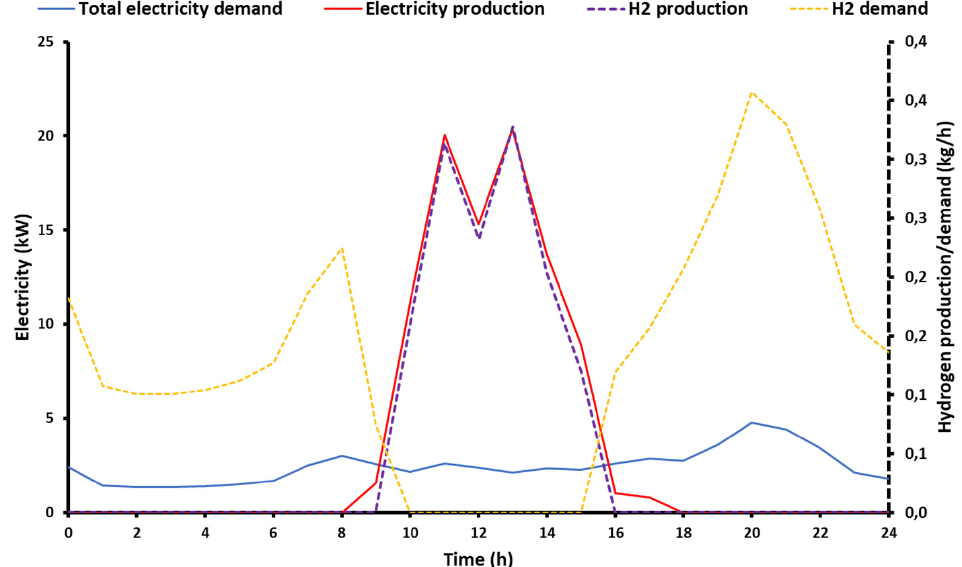
Figure 11. Winter Day: Variation in the electricity demand/production and hydrogen demand/production.